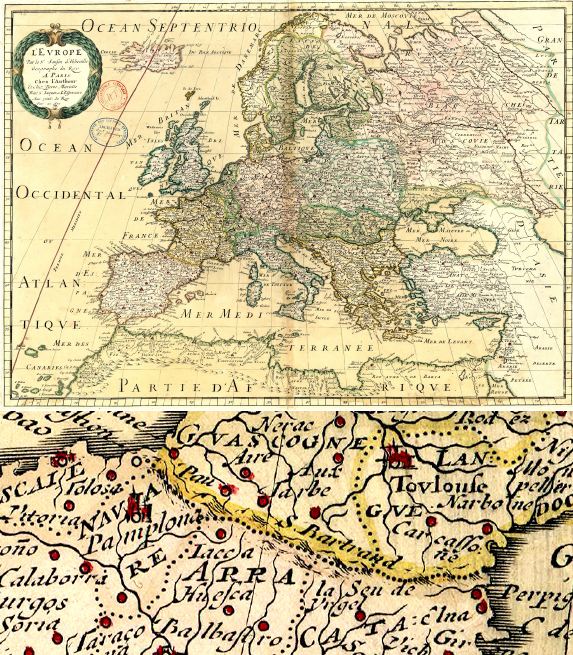
Figure 7: Nicolas Sanson, 1651, L’Europe : Two-colour border and solid-coloured states